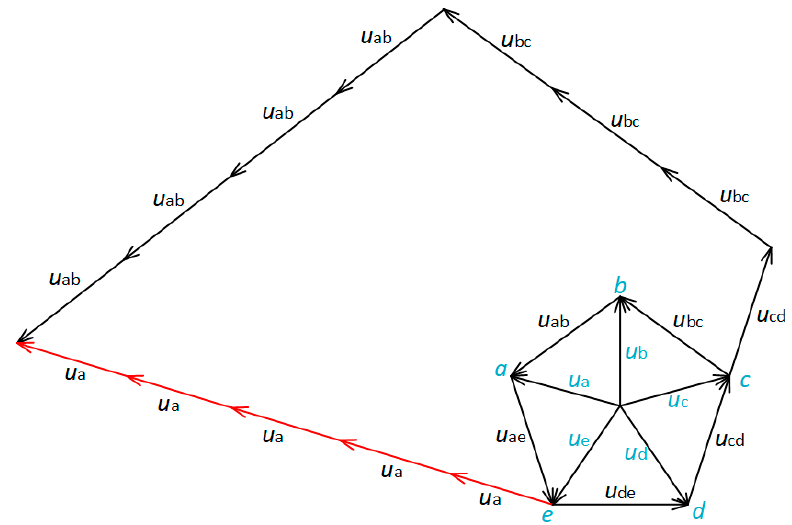
Figure 6. Mutual dependence between the phase voltage U a and the appropriate voltage vectors: 5 U a = 4 U ab + 3 U bc + 2 U cd + U de .